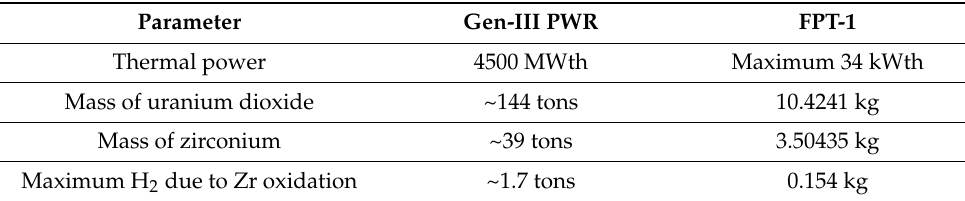
Figure 2. Comparison of axial power profiles. FPT-1 profile, top peaked PWR profile, and PWR FPT-like profile interpolated to normalized axial levels. Table 1. Comparison of basic design details for PWR and